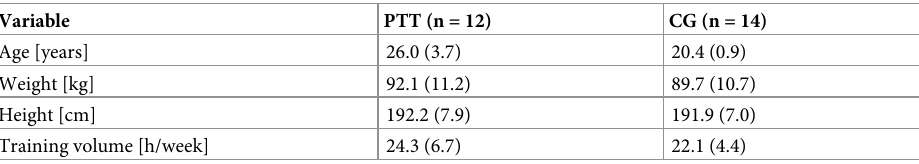
Table 1. Study group